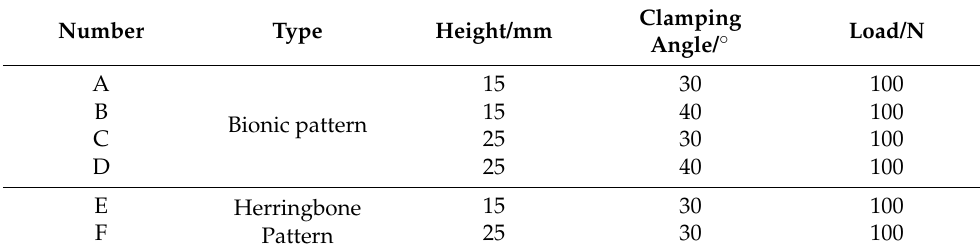
Figure 4. Tire block 3D-model: ( a ) biomimetic tire-block-model; ( b ) Common tire-block-model.0. Table 2. Simulation